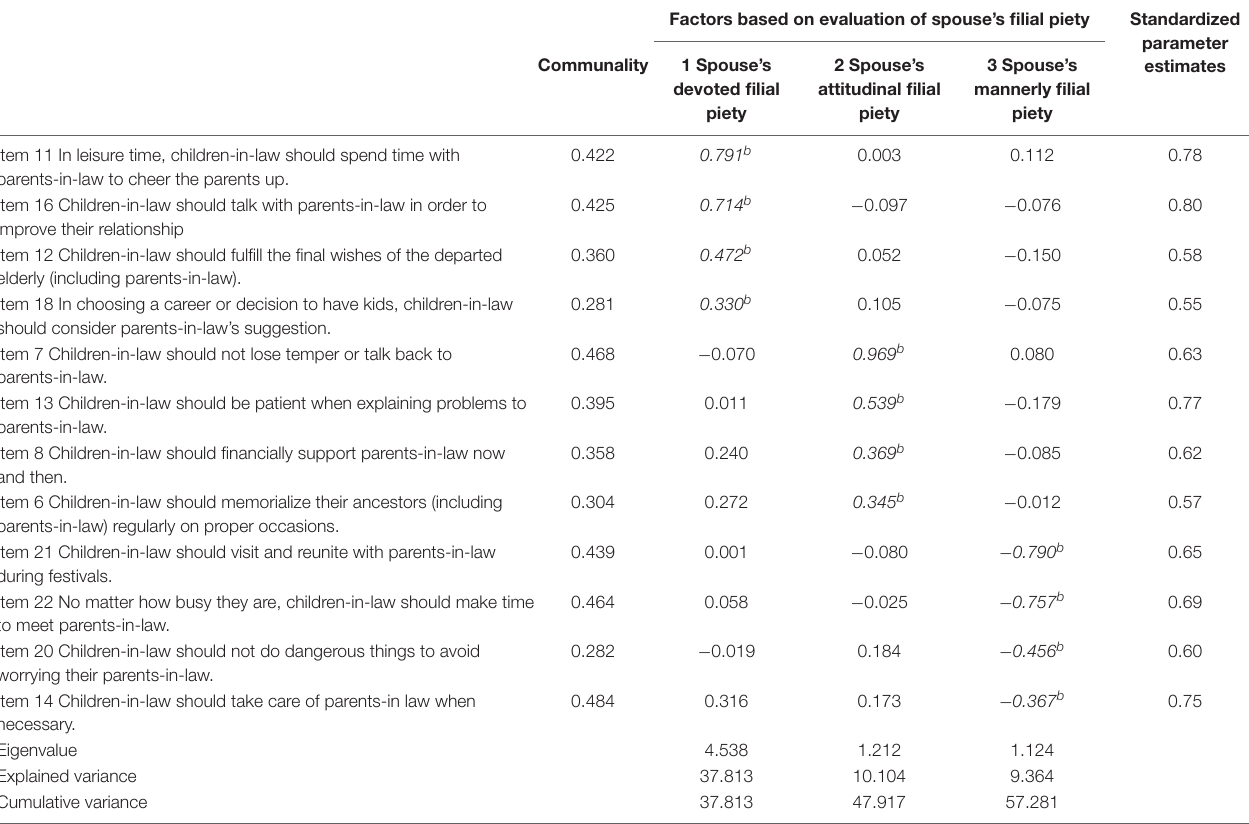
TABLE 1 | Item content and factor structure of the Evaluation of Spouse’s Filial Piety scale a .